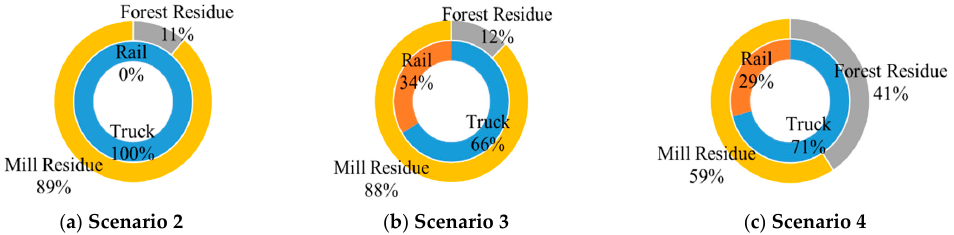
Figure 7. Experimental results on the biomass feedstock type and mode of transportation. ( a